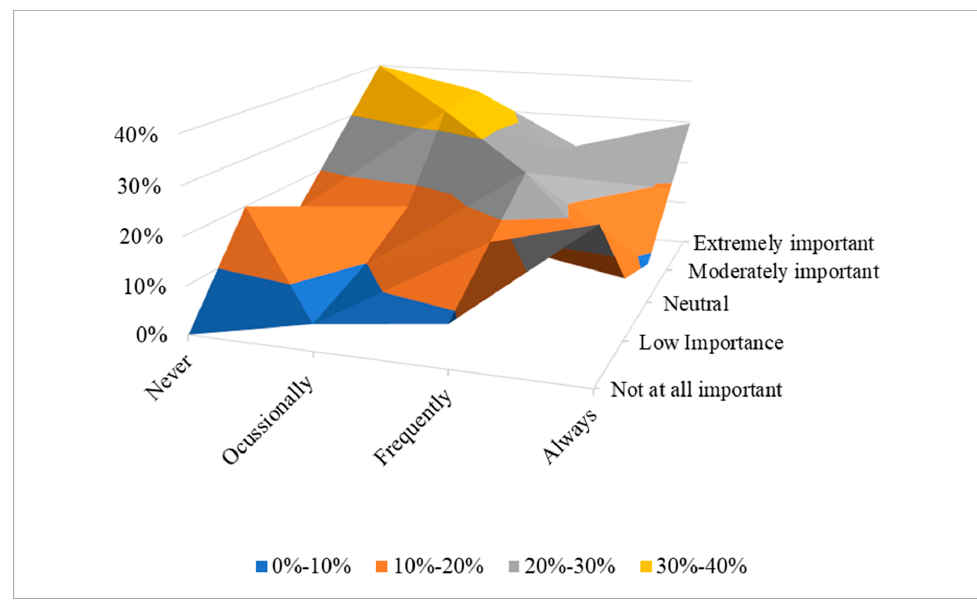
Figure 7. Safety concerns based on SFFES usage categories.